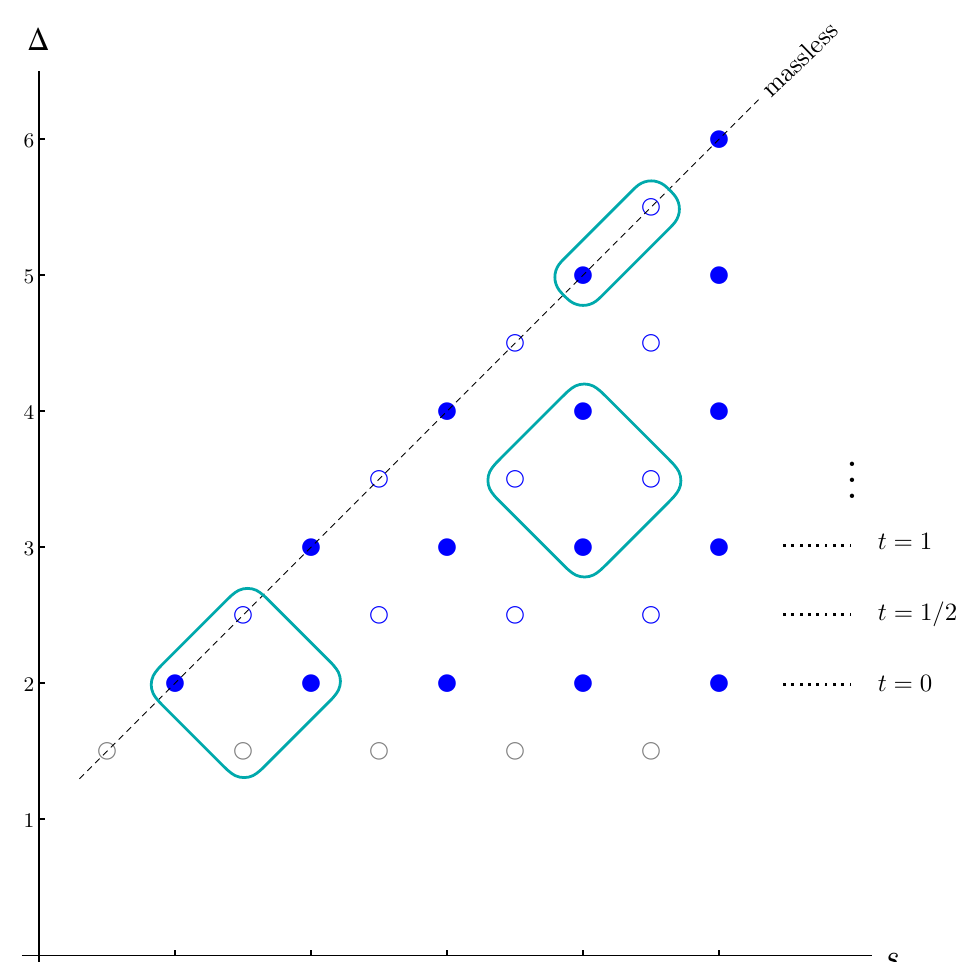
Figure 3 . The N = 1 partially massless multiplets. The (cid:12)lled circles are bosons, the hollow circles are fermions. The blue circles are the partially massless points, the grey open circles on the bottom row at (cid:1) = 3 = 2 are massive fermions that participate in some of the multiplets. The multiplets (cid:8) 3 (cid:9) are all diamonds containing four (cid:12)elds, like the example diamonds illustrated which show the 3 2 2 partially massless spin-2 representation (4.1) as well as the f 4 g representation which contains only 3 partially massless (cid:12)elds. The diamonds degenerate at the top due to the shortening condition (3.33). These are the familiar unitary massless multiplets, and in these short multiplets there are only two massless particles, like the f 4 g example 5